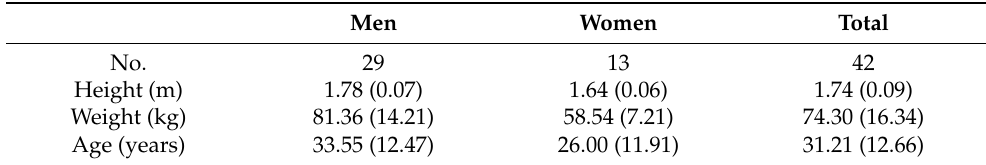
Table 1. Overall participant characteristics given as mean